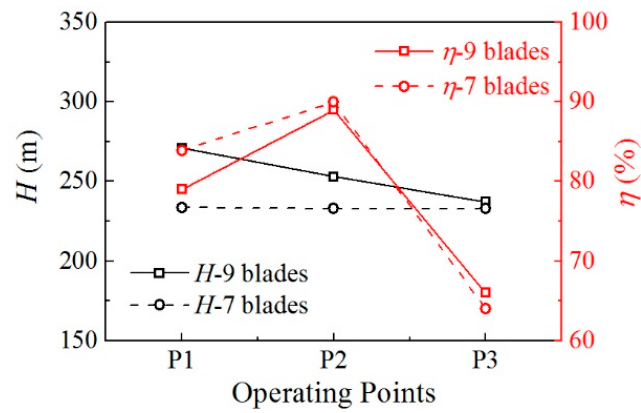
Figure 18. Comparison of hydraulic performance (head and efficiency) with 9 blades and 7 blades.